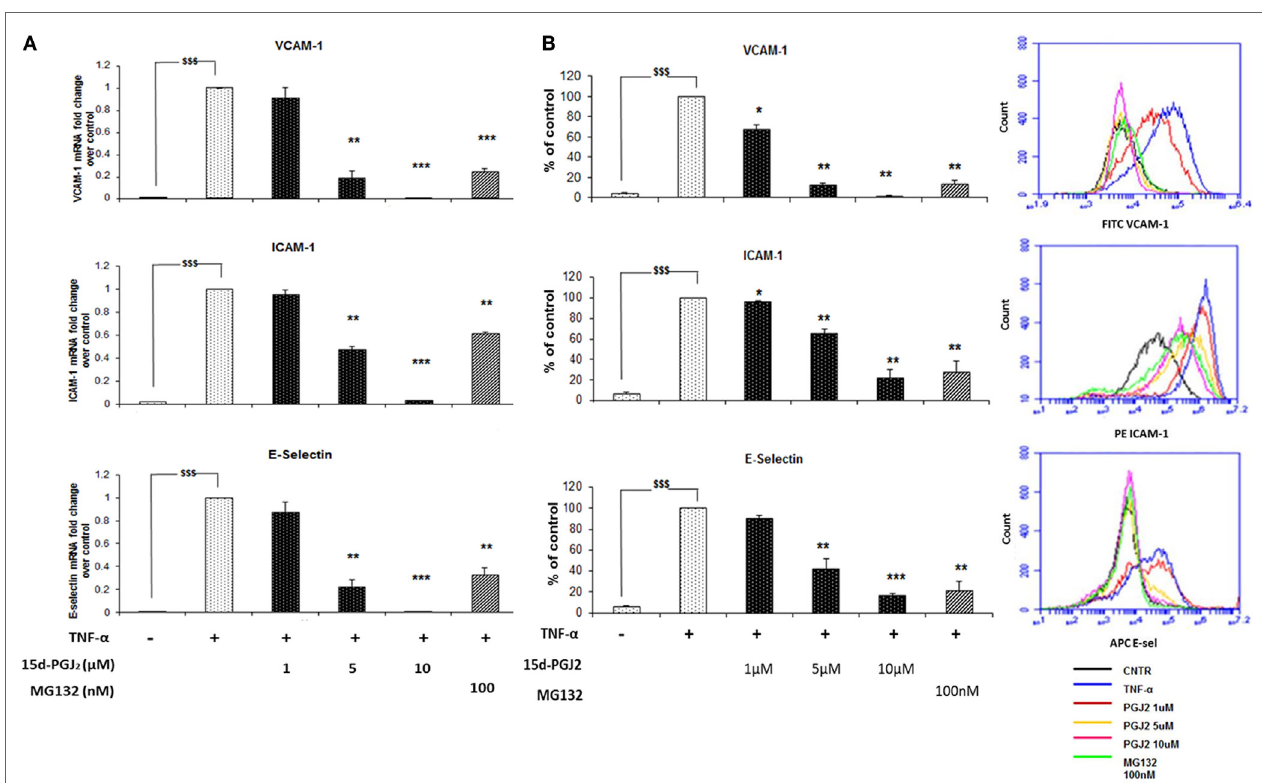
FigUre 4 | 15d-PgJ 2 inhibits mrna expression of adhesion molecules . (a) VCAM-1, ICAM-1, and E-selectin gene expression was performed in EC treated with 15d-PGJ 2 (1–10 μ M) or MG132 (100 nM) for 18 h, followed by 6 h stimulation with TNF- α (0.2 ng/ml). The treatment of EC with 15d-PGJ 2 inhibited gene expression of all the adhesion molecules in a dose-dependent fashion. Similar effects were obtained in the MG132-treated samples. Data are expressed as mean ± SEM of three independent experiments. (B) The quantification of protein surface expression levels of the adhesion receptors VCAM-1, ICAM-1, and E-selectin was performed by flow cytometry analysis on TNF- α -activated EC (6 h, 0.2 ng/ml) pre-incubated with various concentration of 15d-PGJ 2 or MG132 (100 nM). Results show a dose-dependent decrease of protein levels in EC treated with the 15d-PGJ 2 , as well as MG132. Data are expressed as mean ± SEM of three independent experiments. Data shown as percentage of control (vehicle + TNF- α -activated EC); $$$ ( p < 0.001) vehicle vs. TNF- α ; *** p < 0.001, ** p < 0.01, and * p < 0.05 15d-PGJ 2 or M132 vs. TNF- α